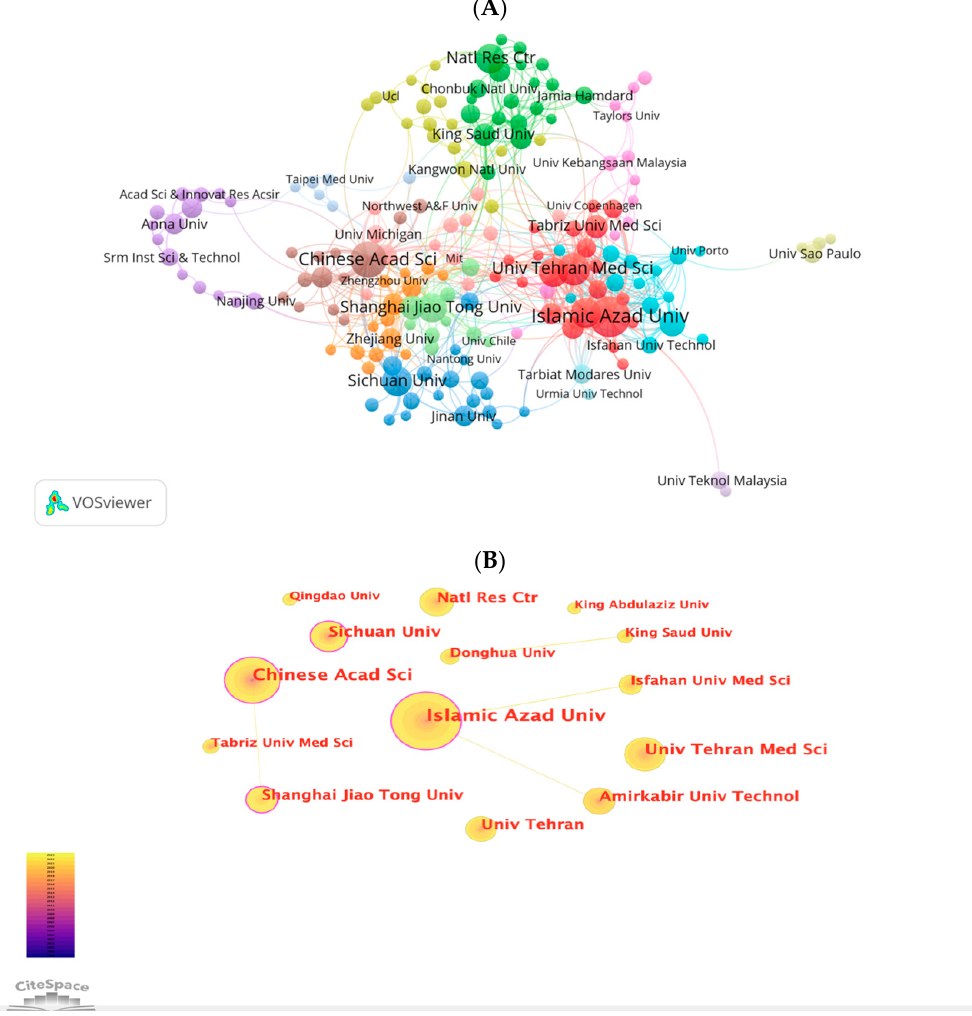
Figure 6. ( A ) The network map of institutions for NDSRSs in the wound healing field was created by CiteSpace. ( B ) The cooperation network of the top 20 institutions generated by VOSviewer.